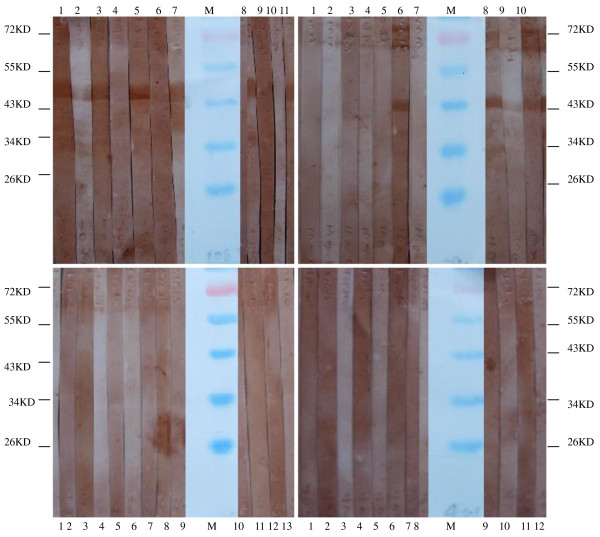
Part of the results of the detection of IgM against s108 (EV71) VP1 (A), s67 (EV71) VP4 (B), s390 (CA16) VP1 (C) and s401 (CA16) VP4 (D) by Western Blot. Western blot assay using goat anti-human IgM as secondary antibody. Lanes 1-7 in A, lanes 1-9 in B, lanes 1-7 in C and Lanes 1-8 in D represent immunoblotting with sera from patients with acute EV71 infection, and lanes 8-11 in A, lanes 10-13 in B, lanes 8-10 in C and Lanes 9-12 in D represent immunoblotting with sera from patients with acute CA16 infection. M represents molecular weight Marker(Fermentas, #SM0671).